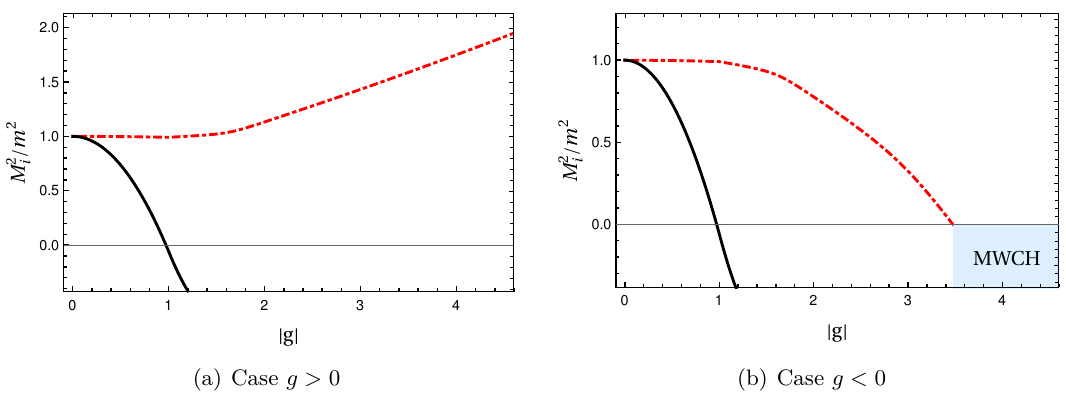
Figure 4 . The pole masses as functions of | g | . The solid line shows M 2 line represents M 2 /m 2 . The same parametrization considered in figure 3 is used φ